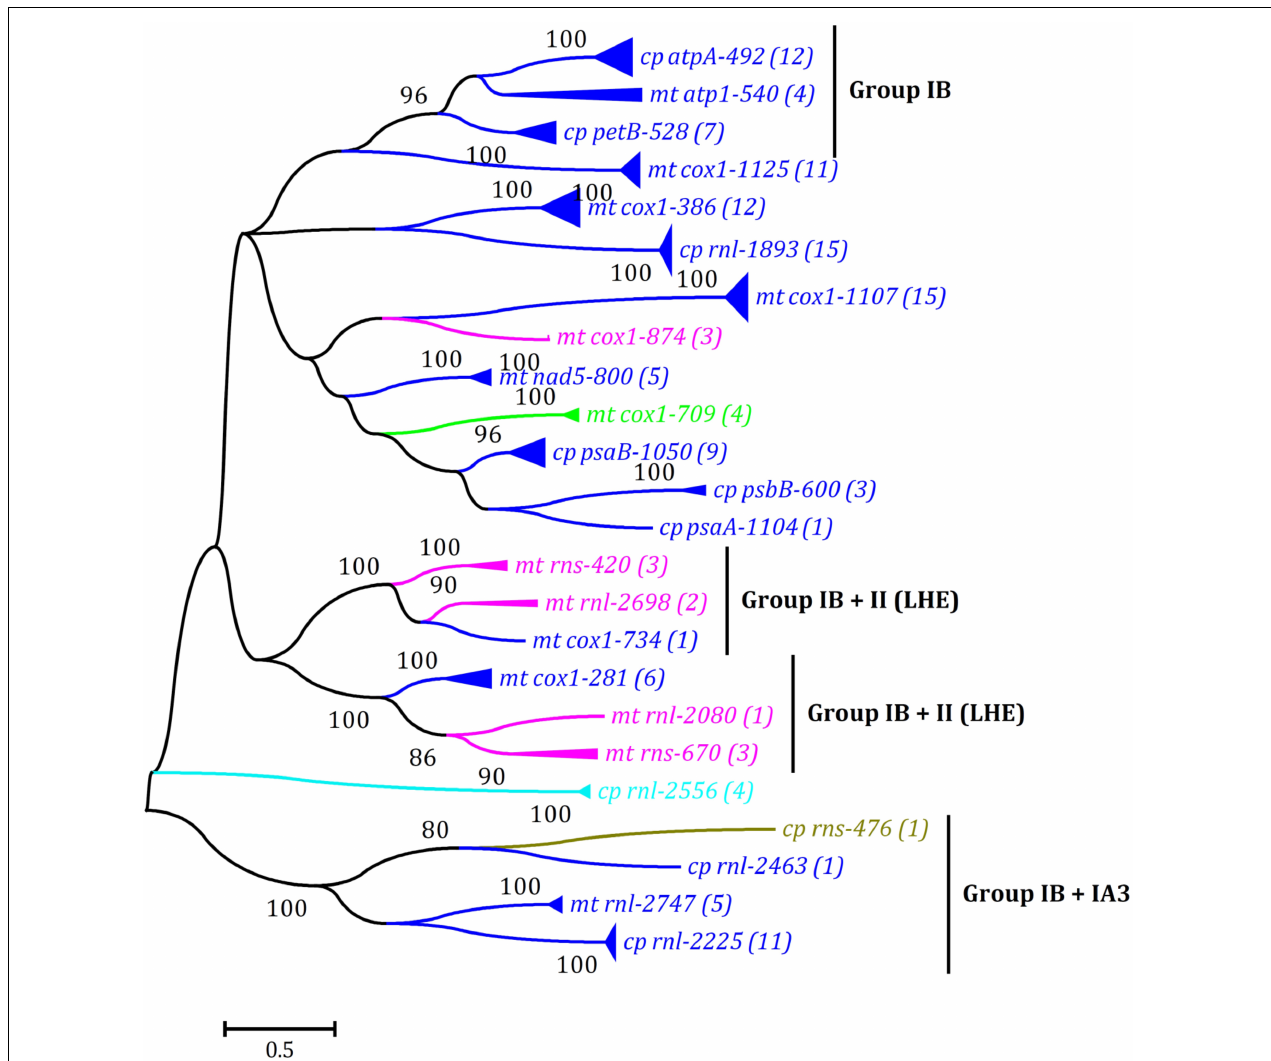
FIGURE 3 | Phylogenetic tree based on Maximum Likelihood (ML) analysis of amino acid (aa) sequences of 139 LAGLIDADG endonuclease domain regions (64 in cpDNAs and 75 in mtDNAs) from five types of introns including group IB (complete), group IA3, group I (derived, B2), group ID, and group II (LHE). Different colored lines denoted LAGLIDADG endonuclease domains from different groups of introns: group IB (complete), blue; group IA3, brown; group I (derived, B2), cyan; group ID, green; and group II (LHE), pink. The ML analysis was conducted with 1,000 bootstrap replicates using MEGA 7.0. The bootstrap support values greater than 80% were displayed at branches. Branch lengths were proportional to the amount of sequence change, which were indicated by the scale bar below the trees. The numbers in parentheses represented the number of LHE proteins from cognate introns. The complete phylogenetic tree was shown in Supplementary Figure 1